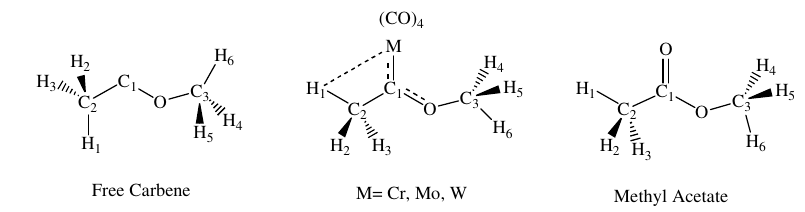
Figure 2 . The numbering system used in this